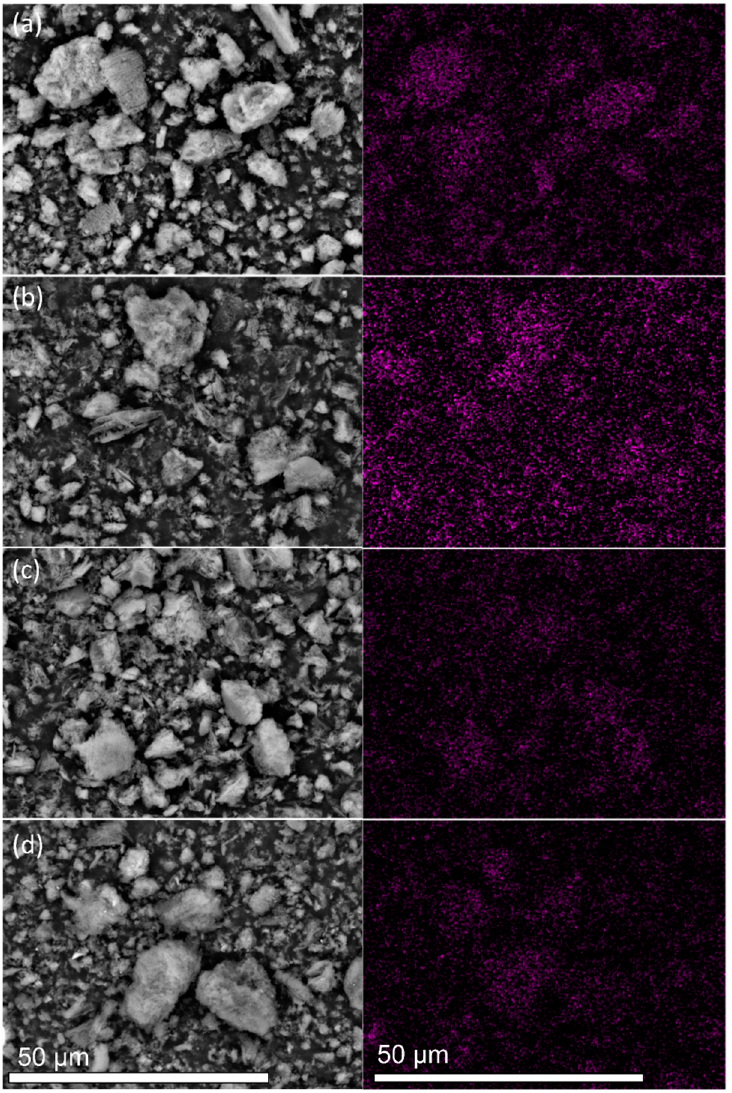
Figure 2. SEM images and the corresponding EDS Pt elemental mappings of the ( a ) Pt/CN-140, ( b ) Pt/CN-160, ( c ) Pt/CN-180, and ( d ) Pt/CN-220 photocatalysts. Table 1. Physicochemical and band gap values of the Pt/CN photocatalysts.